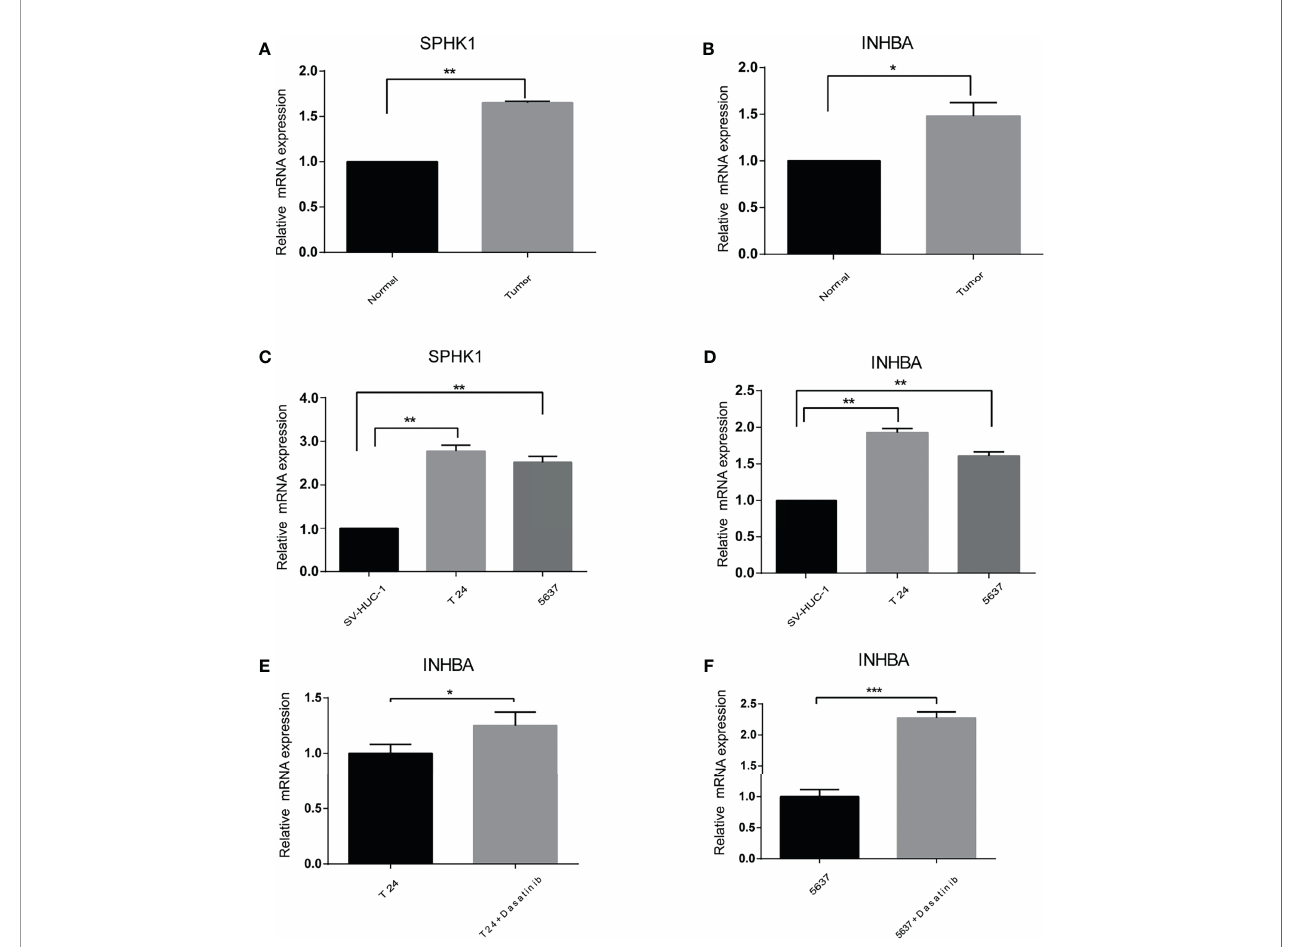
FIGURE 9 | The difference of the prognostic gene expression was con fi rmed by qRT-PCR. (A, B) In vivo . (C, D) In vitro . (E, F) Presence or absence with Dasatinib in vitro . *p < 0.05, **p < 0.01, ***p <